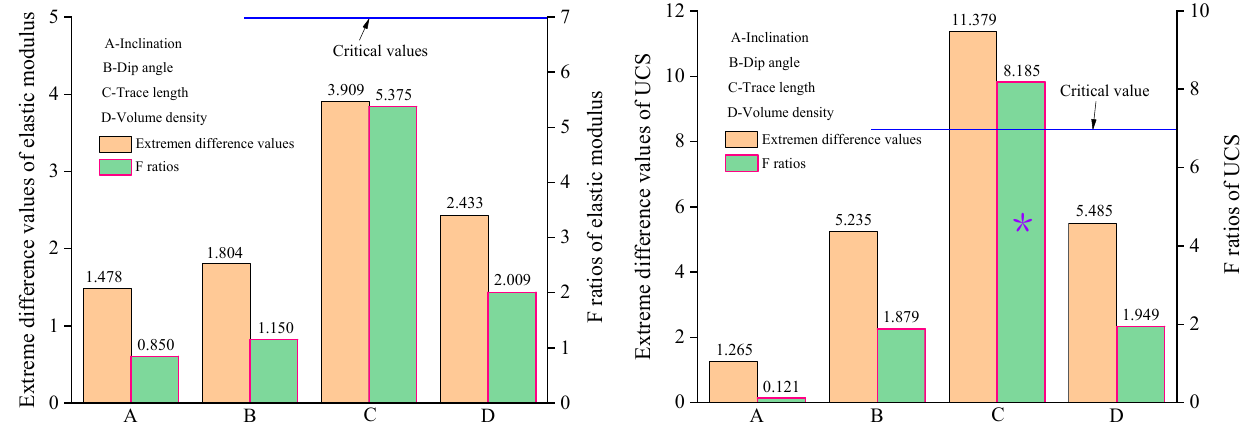
Figure 8. Extreme difference values and F ratios under various influencing factors of the Group 2 test.